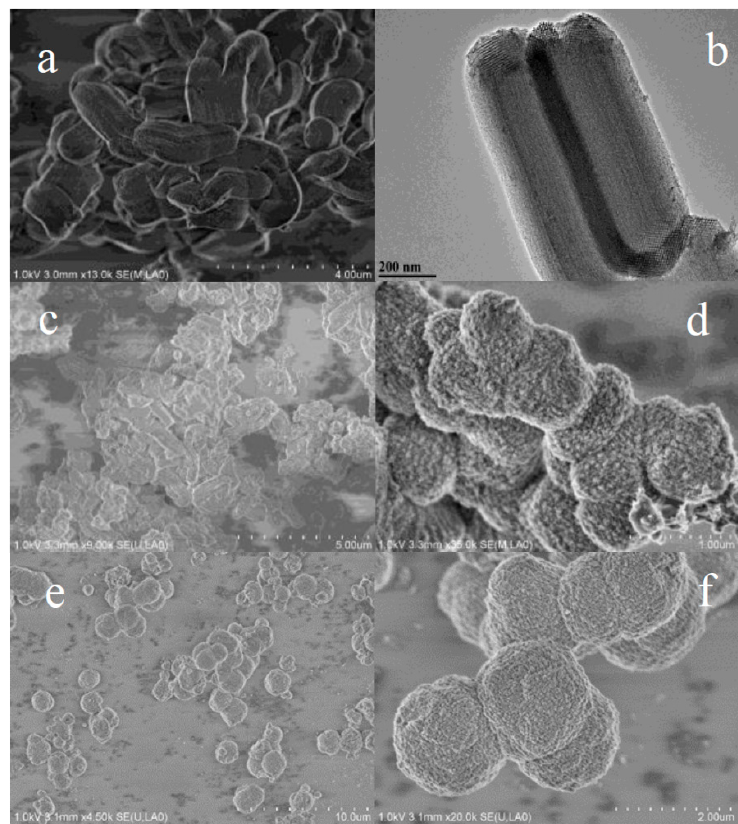
Figure 1. SEM images of SBA-15(a), MCSI-0.4 (c) (calcined at 1023K in N 2 ), HPZ-CSI- x (d, e, f) (calcined at 823K in O 2 ), (TEM images of SBA-15(b)).